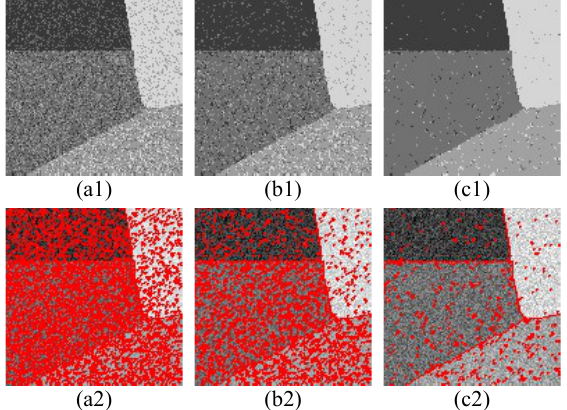
Figure 3. Segmentation result of the simulated image with comparing algorithms.